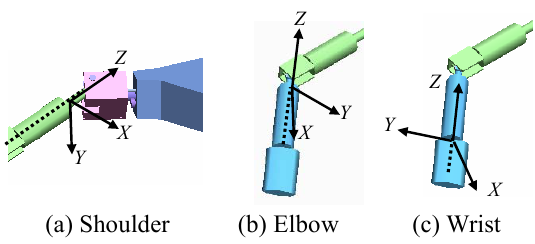
Fig. 8 Local co-ordinate system for bending moment